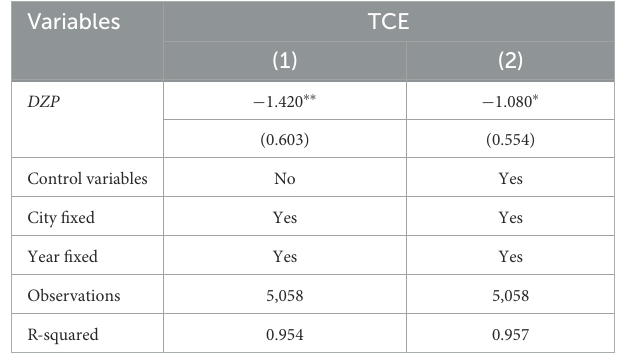
TABLE 6 Regression results for samples that remove